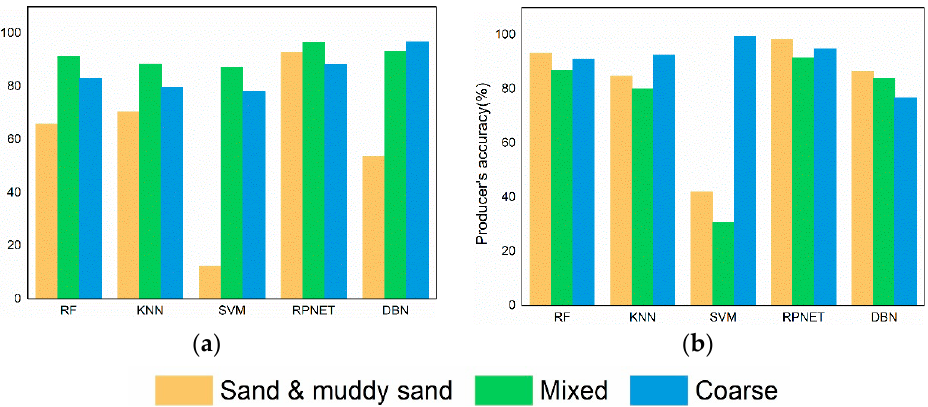
Figure 10. Producer’s accuracy of the RPNet and the traditional classification methods. ( a ) S1; ( b ) S2.